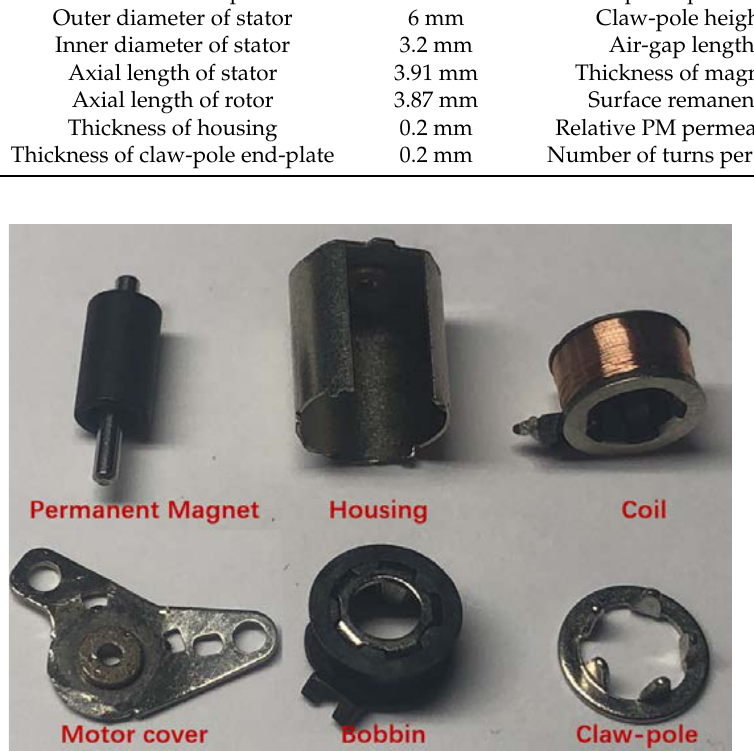
Figure 1. Structure diagram of a micro claw-pole stepper motor.